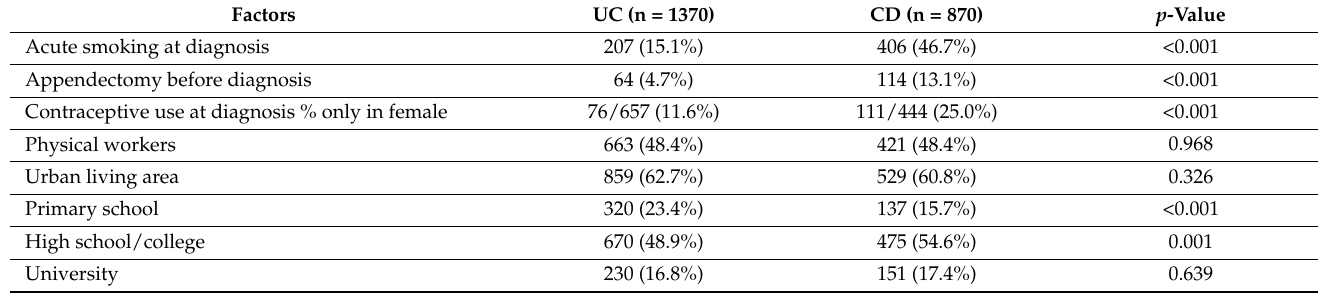
Supplemental Table S2. The trends of key environmental risk factors in UC and CD are shown in Figure 1. The trend of socio-economic factors is shown in Figure 2.